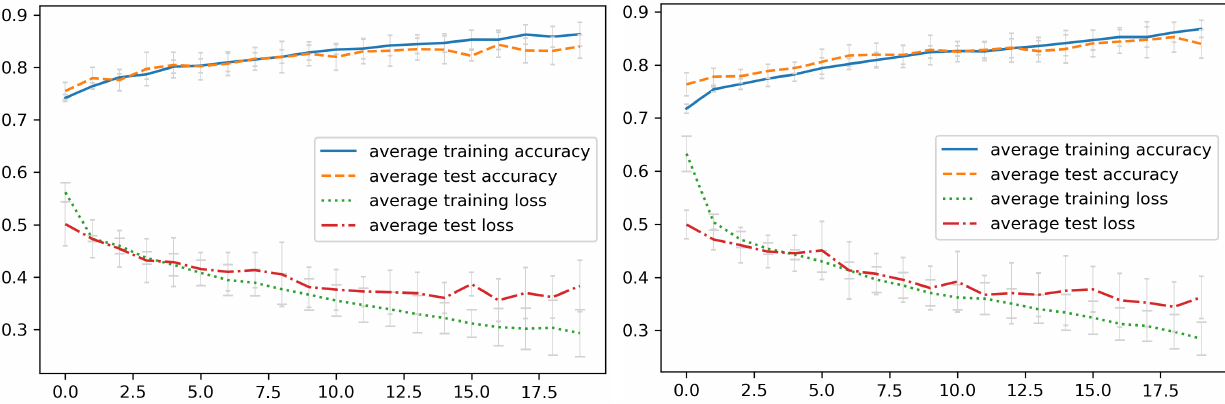
Figure 16. Summary of average results for 20 iterations. Class 0 vs. All. Model: the LeNet model from Figure 5 was applied. Cross-validation 5. Accuracy for 20 iterations of neural network training and corresponding cross-entropy loss.